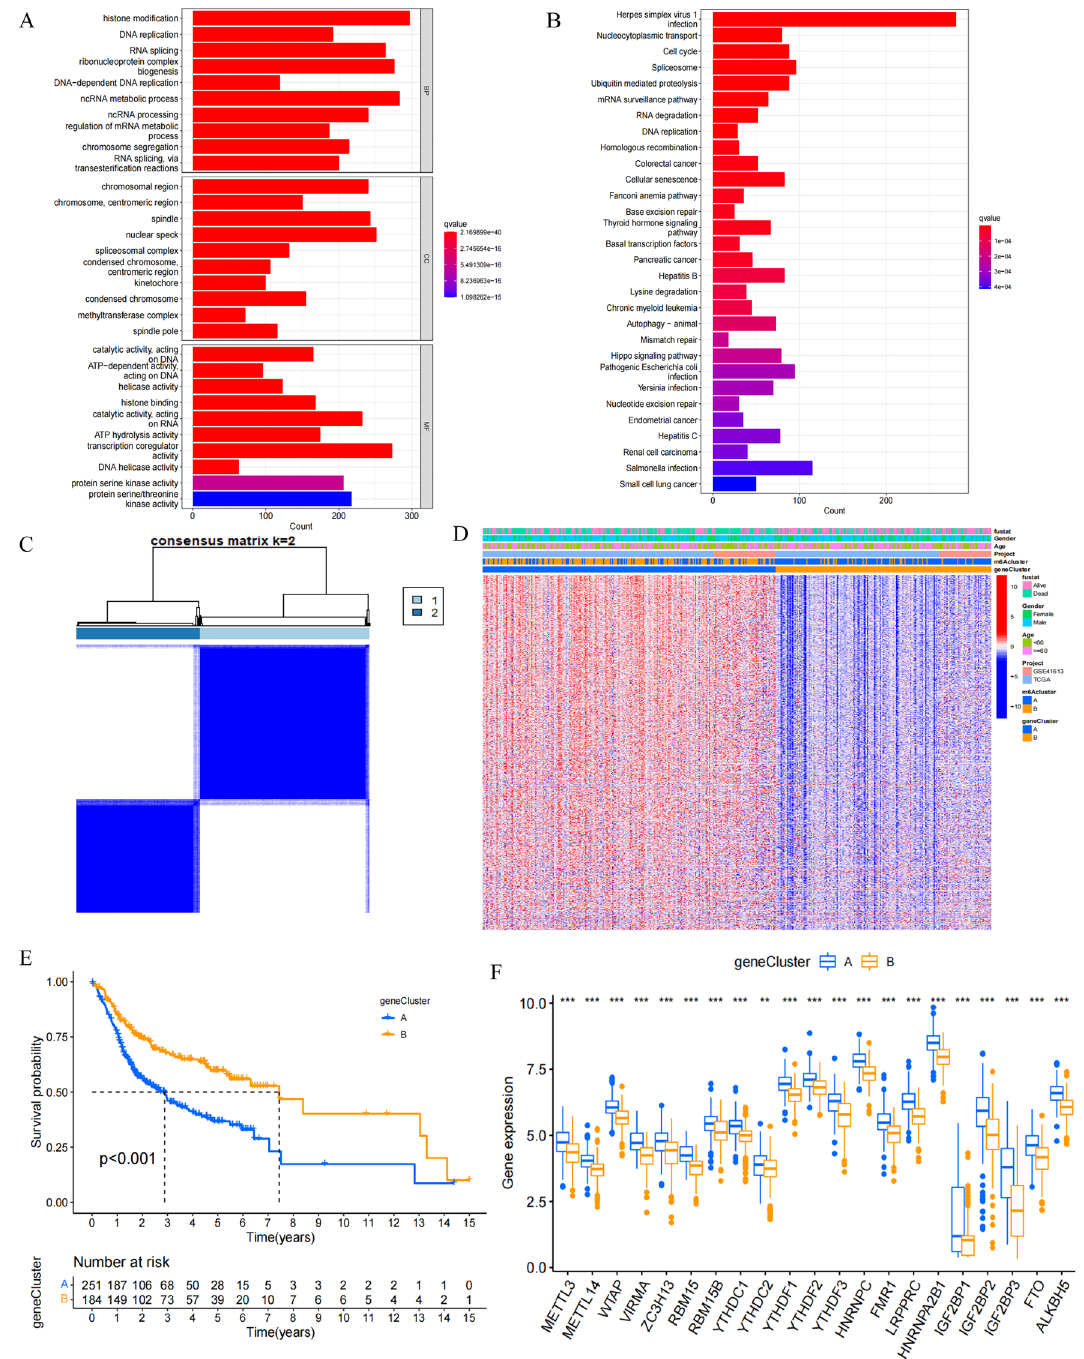
Figure 4. DEGs associated with prognosis. ( A ) Functional annotation of DEGs by GO enrichment analysis. The color depth of the barplot represented q value and the length of the barplot represented number of enriched genes. ( B ) Functional annotation of DEGs by KEGG enrichment analysis. The color depth of the barplot represented q value and the length of the barplot represented number of enriched genes. ( C ) Consensus clustering analysis of prognosis related genes. Consensus clustering matrix for k = 2. Gene cluster A, 1; Gene cluster B, 2. ( D ) Unsupervised clustering of prognosis related genes in OSCC patients from TCGA and GSE41613 cohort. Fustat, gender, age, project, m 6 Acluster and gene cluster were used as patient annotations. High expression, red; low expression, blue. ( E ) Kaplan–Meier survival analysis of OSCC patients in different gene clusters. Gene cluster A, blue curve; Gene cluster B, yellow curve. Log-rank p < 0.001 showed a significant survival difference between two gene clusters. ( F ) Differential expression of m 6 A regulators between gene cluster A and gene cluster B. Gene cluster A, blue; Gene cluster B, yellow. Top edge of box: upper quartile; bottom edge of box: lower quartile; internal horizontal line: median. Dots above and below: outliers. *p < 0.05; **p < 0.01; ***p <